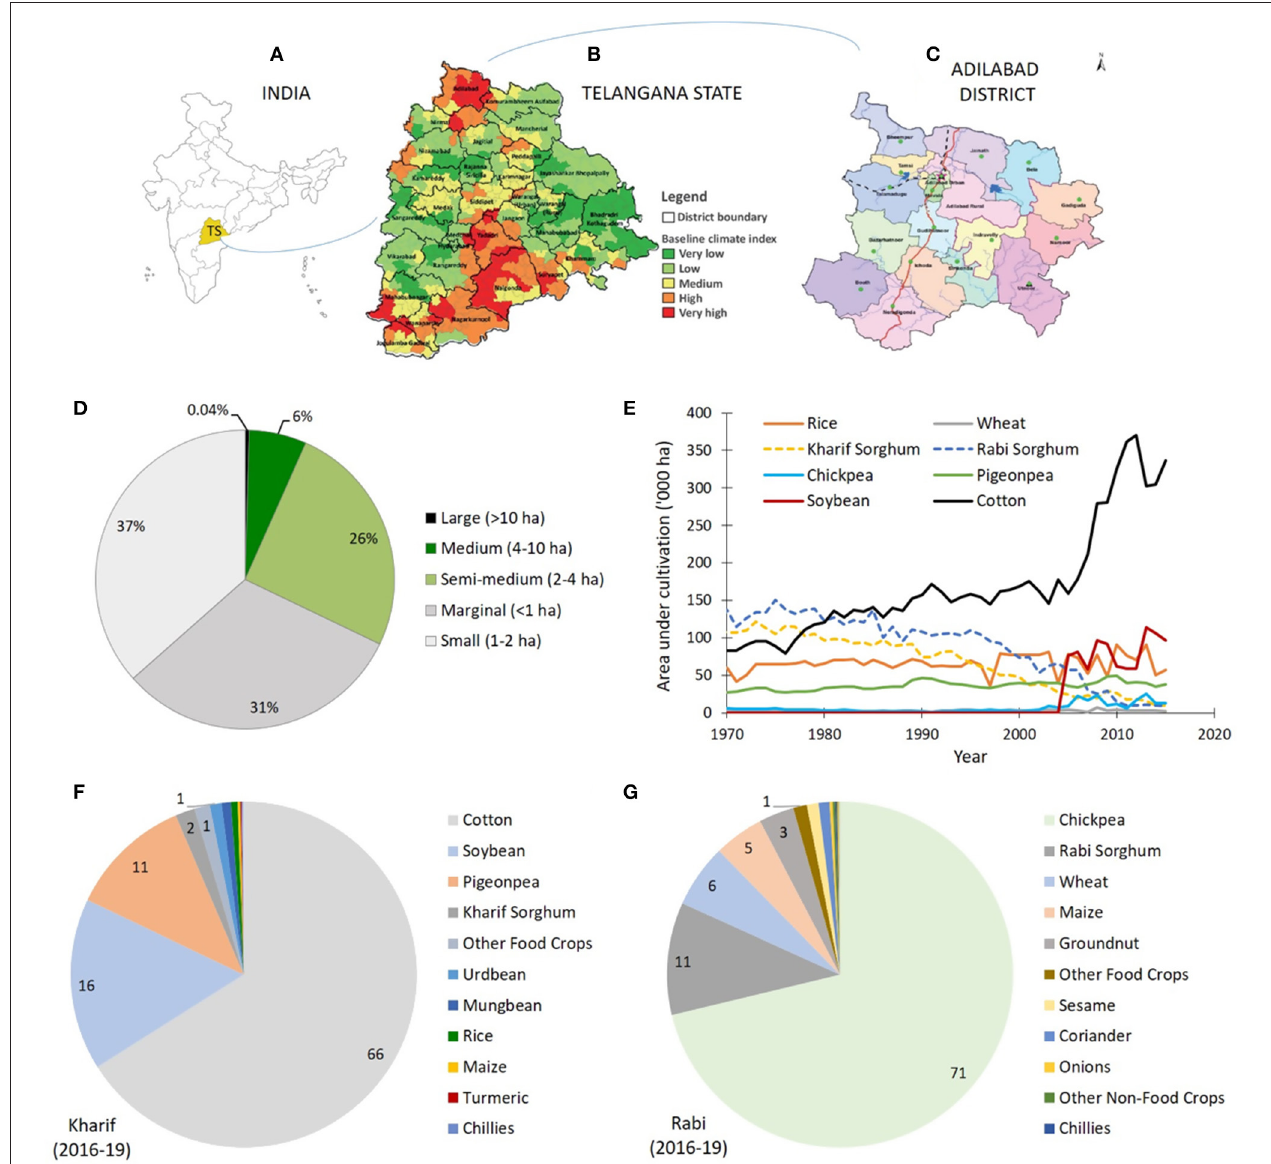
FIGURE 1 | Matrix of figures related to Adilabad district. (A) Telangana state in India (Source: https://www.vectorstock.com/royalty-free-vector/telangana-vector- 3170092); (B) Climate-exposure index for Telangana state (Source: Kumar et al., 2018); (C) Mandals in Adilabad district; (D) Composition of farmers based on landholding in Adilabad district (2016 data, http://adilabad.telangana.gov.in/keystatistics/); (E) Trend of area under cultivation of major crops cultivated in Adilabad (1967–2015 data, http://data.icrisat.org/dld/src/crops.html); (F) Major crops being cultivated in Adilabad across rainy ( kharif ); (G) Postrainy ( rabi ) cropping seasons (2016–19 data,